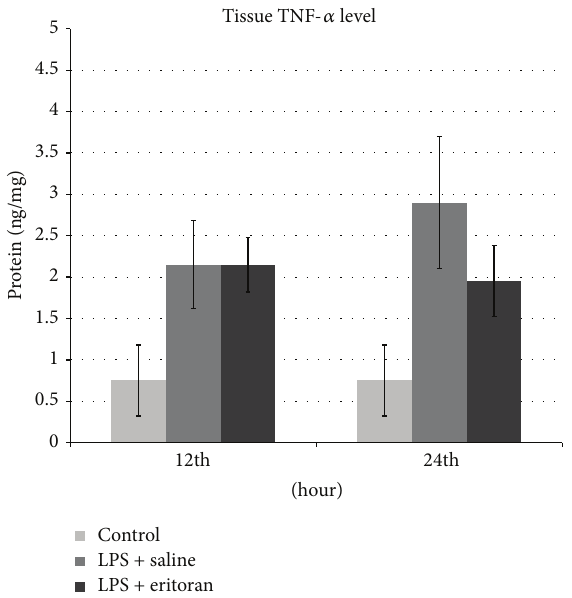
Figure 4: The malondialdehyde (MDA) levels in retinochoroidal tissue after 12 h and 24 h in control group with no intervention, rats with sepsis but without eritoran, and rats with sepsis treated with eritoran. Vertical lines show standard deviation. LPS: lipopolysac- charide.